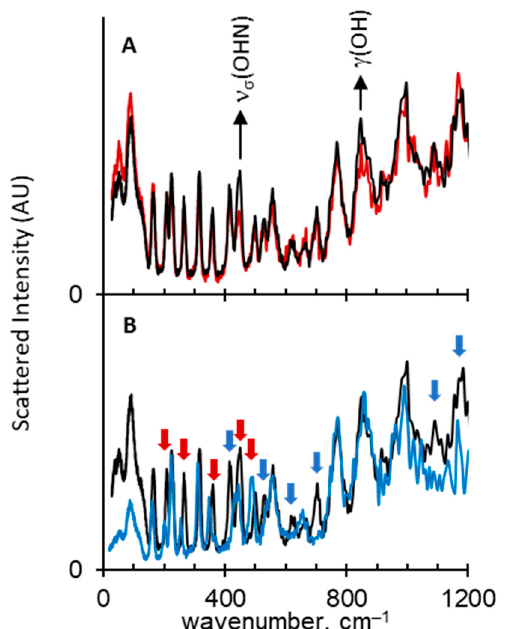
Figure 4. Normalized IINS spectra of SA (black traces), SA-OD (panel ( A ), red trace) and SA-C 6 D 5 (panel ( B ), blue trace). Blue arrows: bands of γ (CH) and τ (CH) vibrations, which disappear after deuteration. Red arrows: bands of various vibrations, which shift after the deuteration. See text for more details.